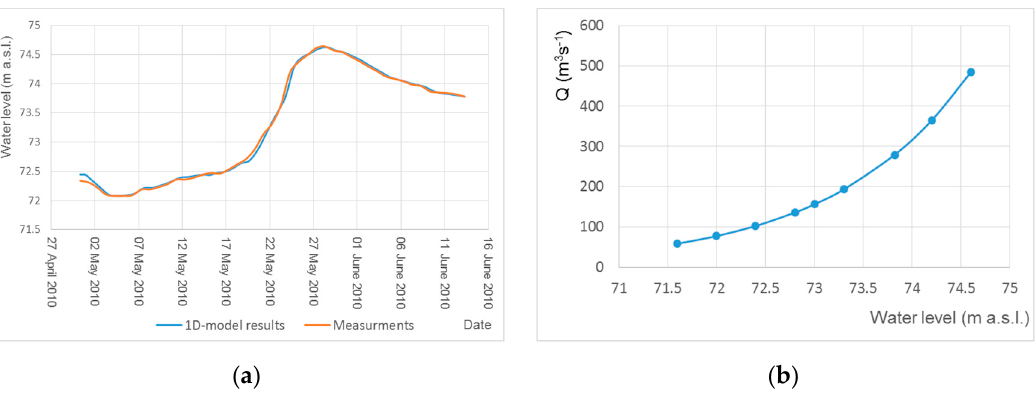
Figure 4. ( a ) The calculated and measured water level hydrographs for the flood of 2010 in the section 352.170; and ( b ) relationship between the water level and flow rate on the basis of the results obtained from the 1D model for the cross-section 351.82.